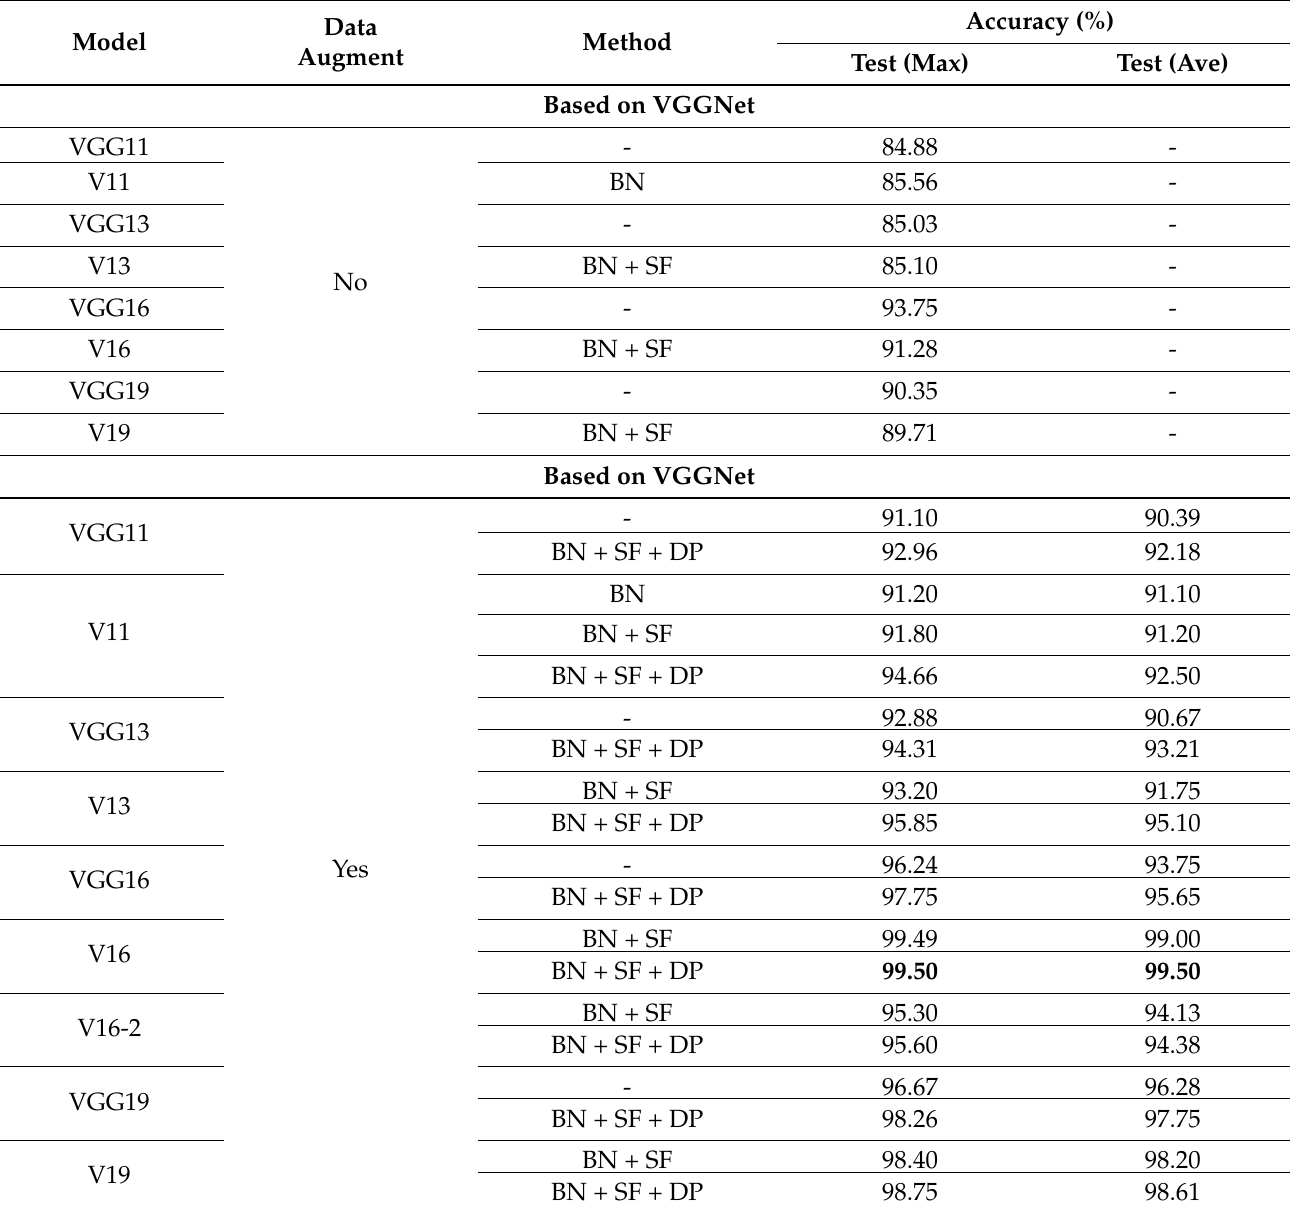
Table 4. Recognition accuracy of VGGNet-based models on unaugmented (No) and augmented (Yes) OBI datasets. VGG n refers to the standard VGGNet model with a n-layer structure. BN, DP, SF represent batch normalization, dropout, and shuffle methods, respectively. Test (max) denotes the maximum recognition accuracy rate and test (ave) represents the average value of the last five accuracy rates after the training is stable. Bold numbers indicate the optimal value of each indicator in each group of network